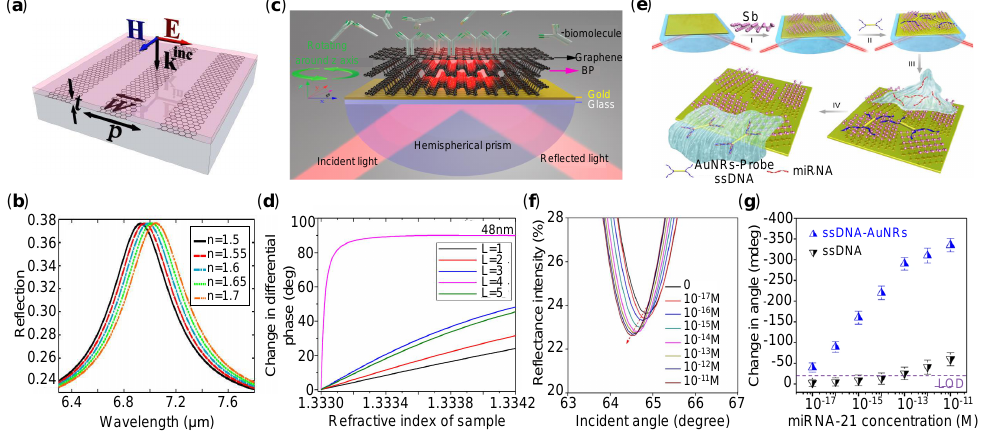
Figure 7. ( a ) Illustration of graphene ribbons. ( b ) Reflection spectra for graphene ribbons covered with different dielectric films at a constant thickness of 2 nm. ( c ) Schematic diagram of graphene–black phosphorous (BP) surface plasmon resonance (SPR) biosensor. ( d ) The change in differential phase with the variation of RI. ( e ) Fabrication process diagram of miRNA sensor integrated with anti- monene nanomaterials. ( f ) Reflection spectra shift for different miRNA-21 concentrations assisted by AuNRs amplification. ( g ) SPR angle shift versus the miRNA-21 concentration. Reprinted ( a , b ) with permission from Reference [166]. Reprinted ( c , d ) with permission from Reference [168]. Reprinted ( e – g ) with permission from Reference [169].